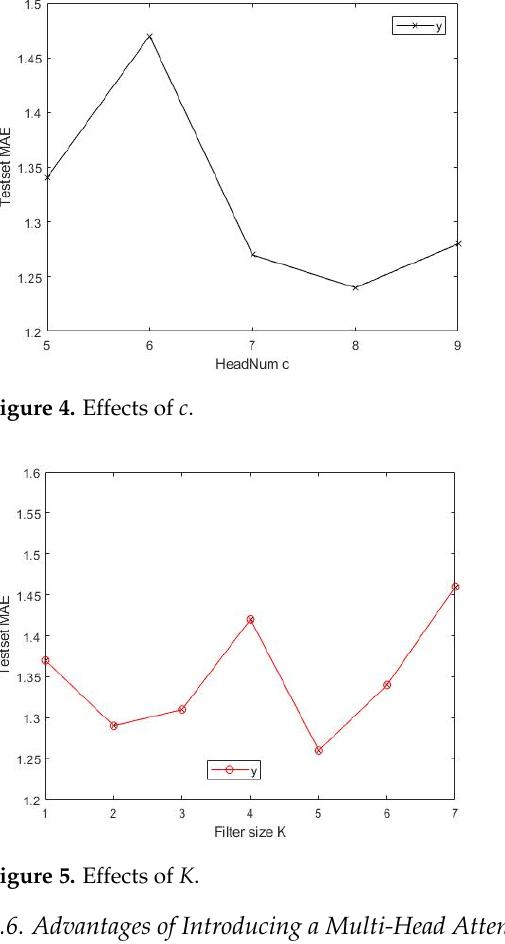
Figure 6. Two indicators evaluated on one day’s test data set.